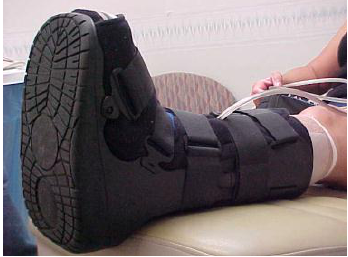
Figure 6. Felt, wrap and boot in place at week seven.